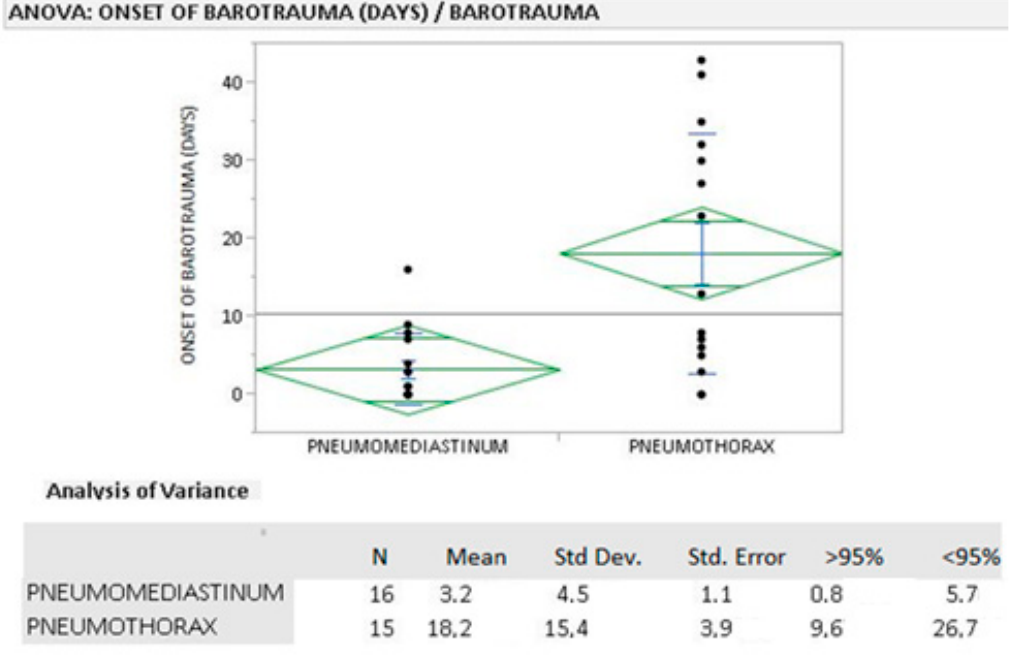
Figure 7. Average time of onset of barotrauma in COVID+ patients.